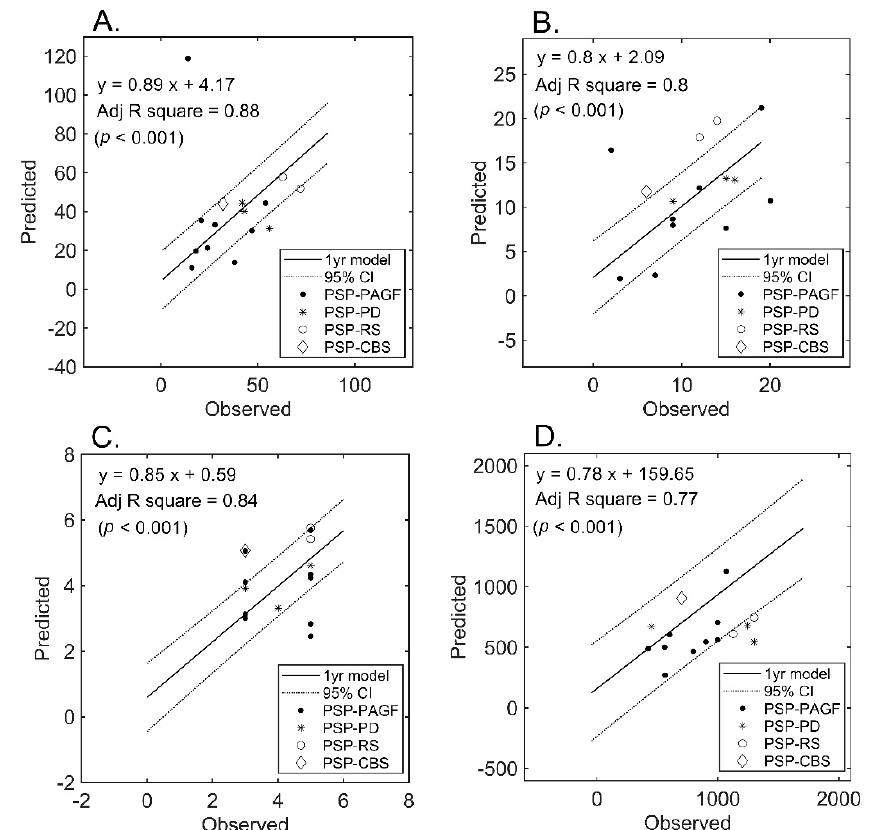
Figure 4. Prediction of severity measures: results of regression analysis in the validation subset. The graphs plot the observed versus predicted values for each severity measure at the individual level in the validation subset ( n = 15). (Panel ( A )): UPDRS-III; (Panel ( B )): PIGD; (Panel ( C )): MHY; (Panel ( D )): LEDD. UPDRS-III, motor subscale of Unified Parkinson’s Disease Rating Scale; PIGD, postural instability and gait disorder staging; MHY, modified Hoehn and Yahr staging; LEDD, Levodopa equivalent daily dose.